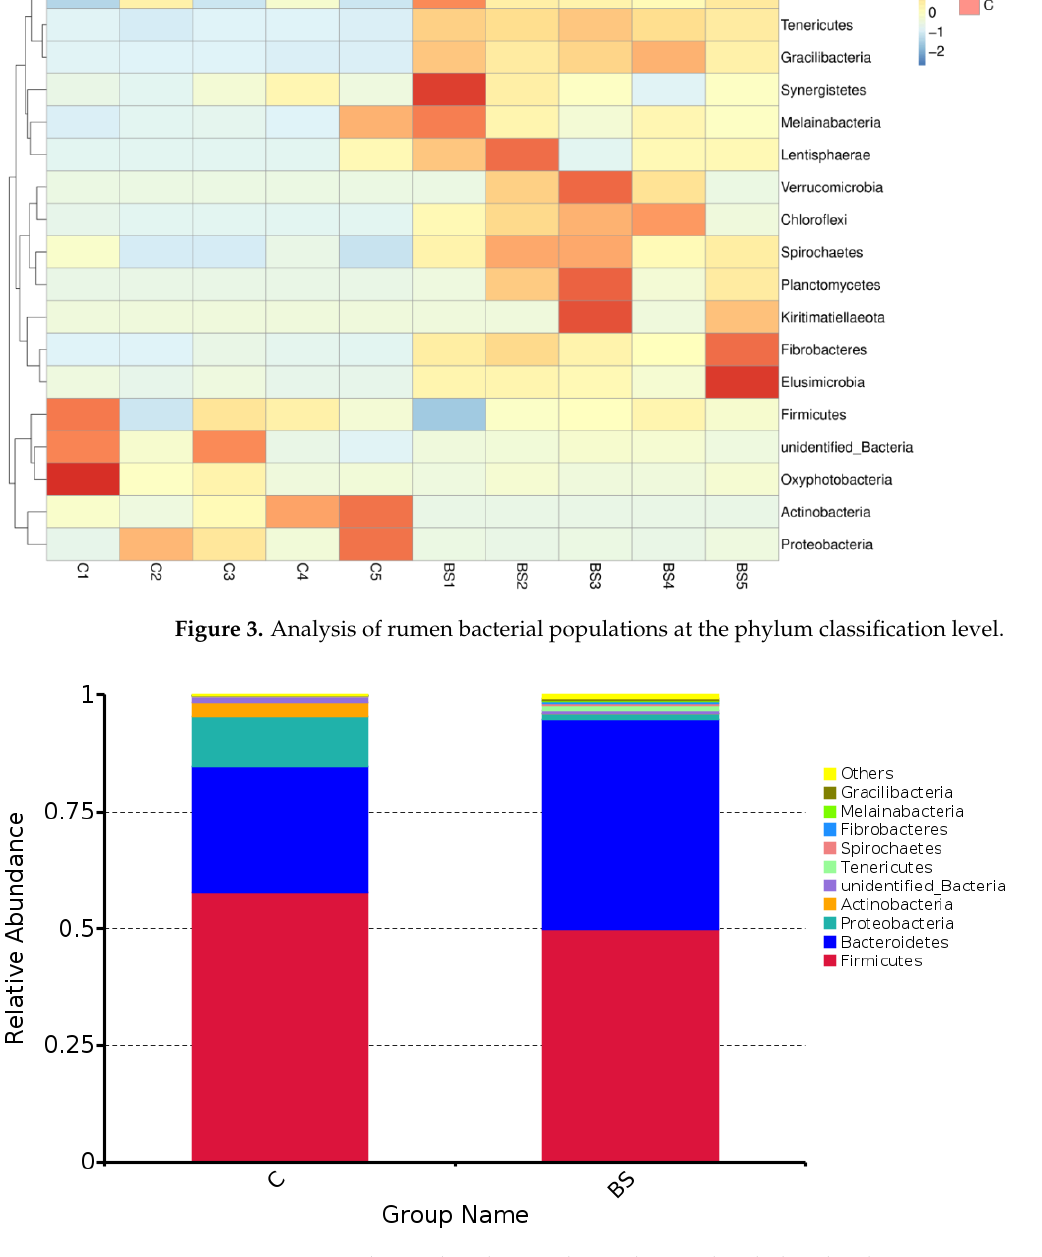
Figure 4. Species relative abundance column chart at the phylum level. Table 4. Abundance (mean ± SE; n = 5; >1%) at phylum level of bacteria in the rumen fluid of lambs fed basal diet only (Control; C) or basal diet supplemented with Bacillus subtilis at the concentration of 3 × 10 8 CFU/kg DM (BS).